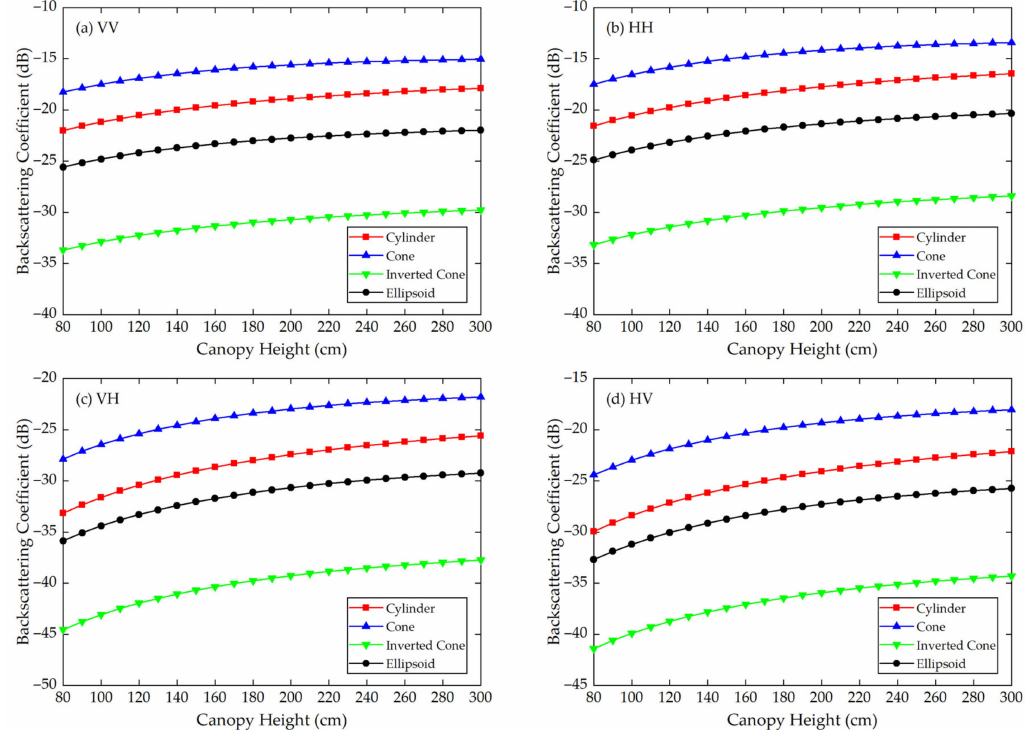
Figure 8. The MTVM simulation results of the backscattering coefficients for different crown shapes in C band (5.3 GHz)